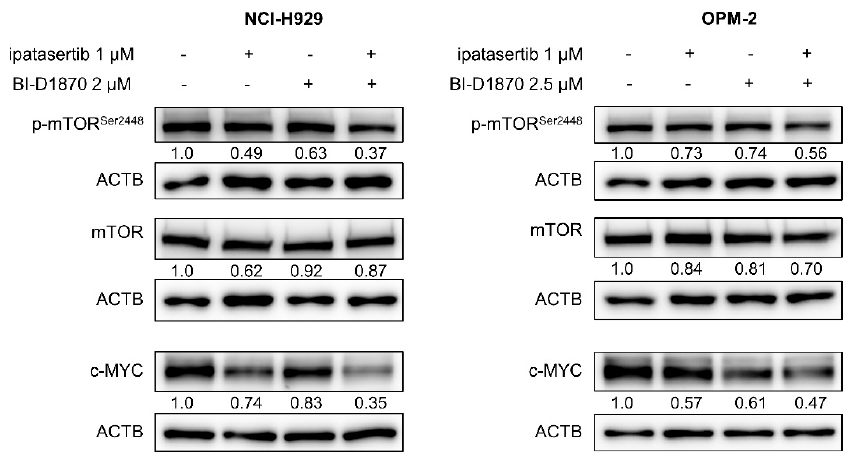
Figure 6. WB for MYC, mTOR, and p-mTOR: Cells were treated for 48 h at the indicated concentra- tions of agents. Expression levels relative to control (untreated cells) are shown below each band measured by densitometric analysis using Image-J software. ACTB was used as an internal control. Table 2. Significantly modulated common gene sets by either BI-D1870, ipatasertib or the combina- tion of BI-D1870 and ipatasertib in NCI-H929 and OPM-2 cells.